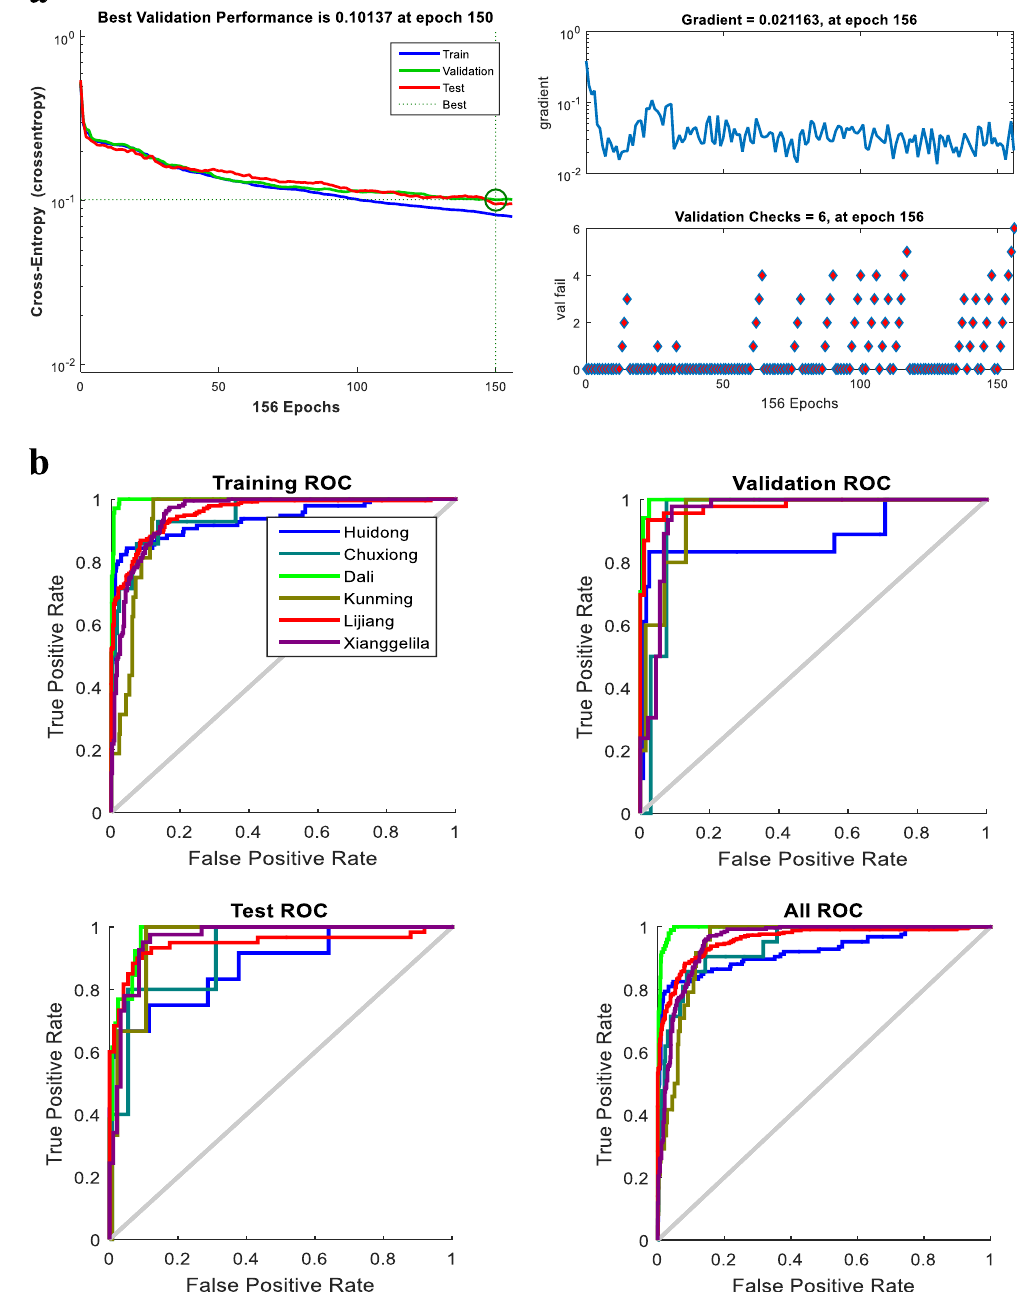
Figure 1. Construction of the BP neural network. ( a ) Performance of the training set. ( b ) ROC curve of the training